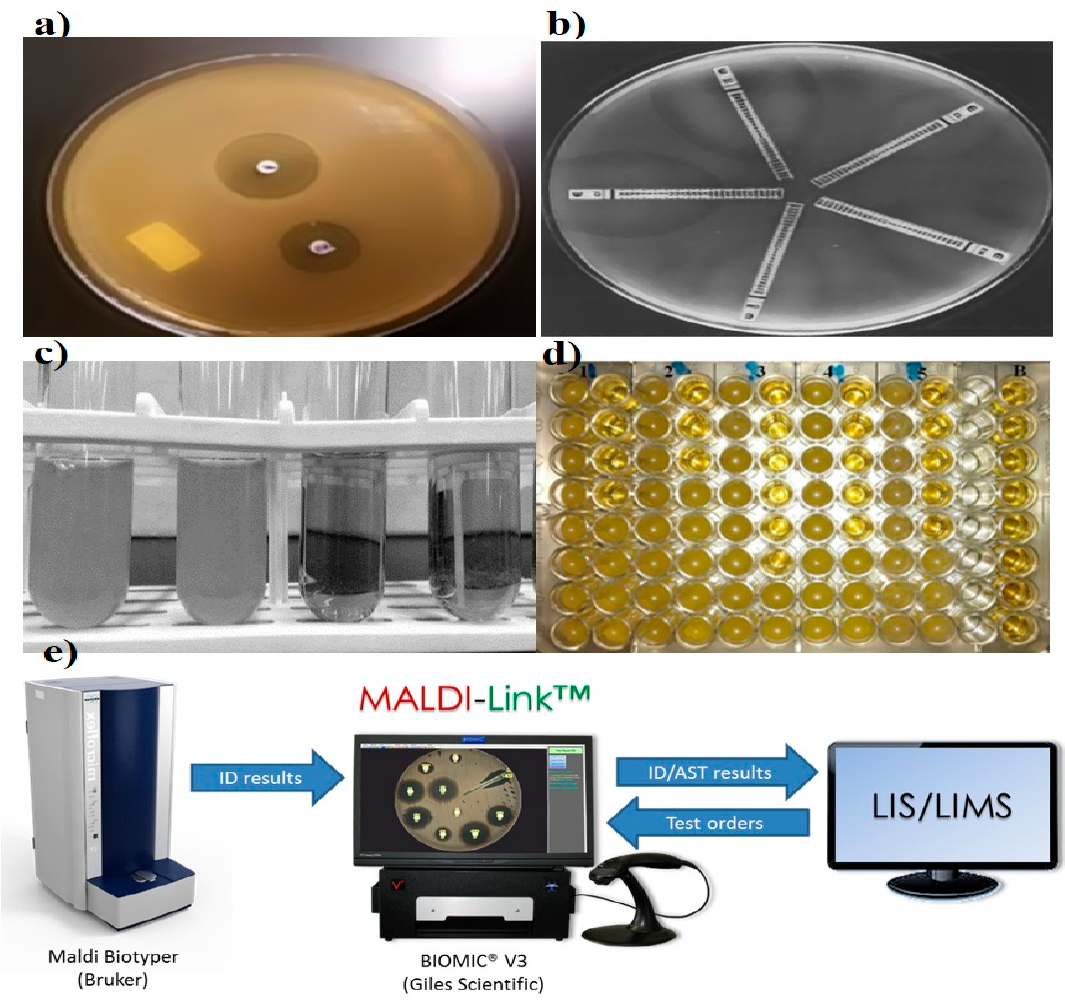
Figure 2. Representation of various conventional antibiotic susceptibility testing methods. ( a ) Disk di ff usion, demonstrating of inhibition zones, adapted from Sageerabanoo [29]. ( b ) Etest gradient disk di ff usion, adapted from Sader [30], under terms of the Creative Commons attribution license. ( c , d ) Broth macro and micro dilution, showing bacterial susceptibility based on optical density and ( e ) Matrix-Assisted Laser Desorption Ionization-Time of Flight Mass Spectrometry (MADI-TOF MS), adapted from the MALDI Biotyper system (Bruker, Billerica, Massachusetts, United States), Laboratory Information System (LIS) and Laboratory Information Management System (LIMS).